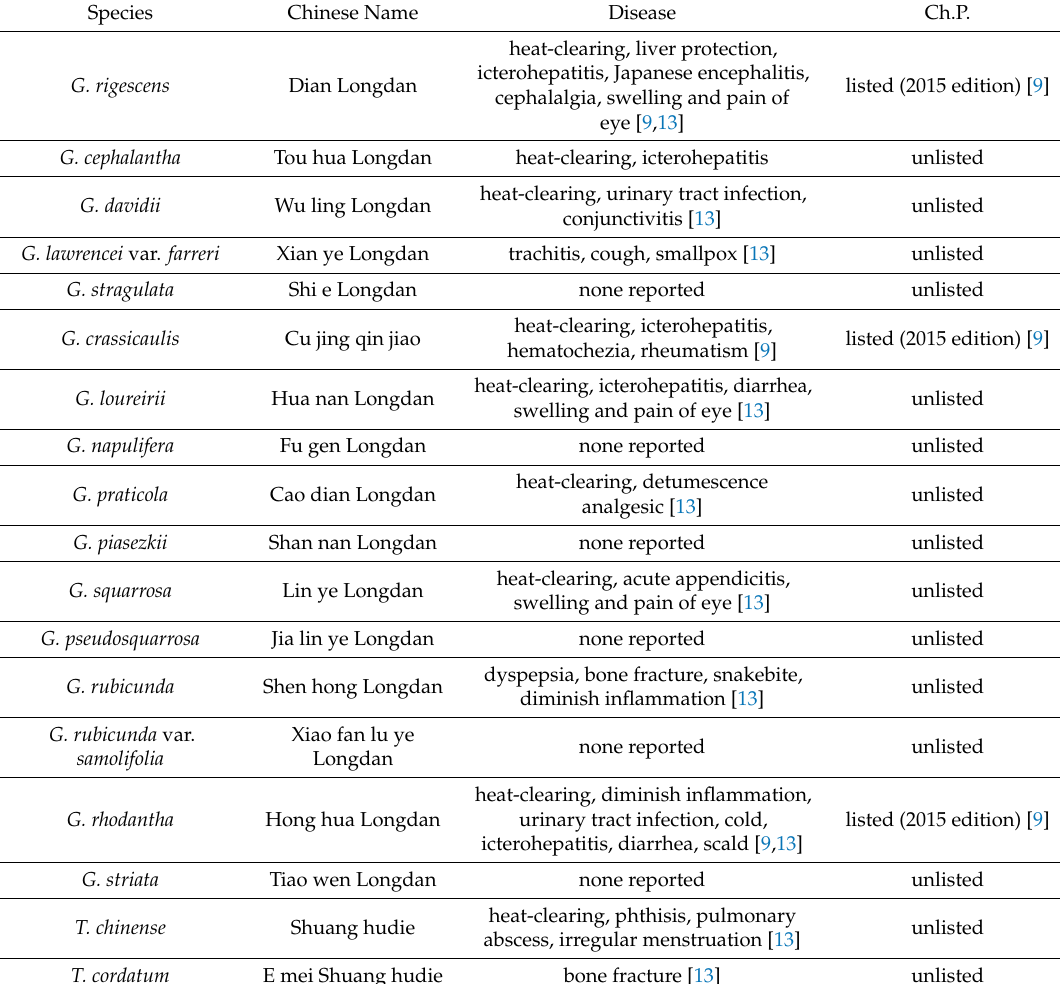
Table 12. Sample information including their application in southwest of China.